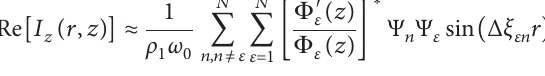
− 10m to 10m; left: point source; right: cylindrical shell). (b) Q ∗ � 360Hz). 0